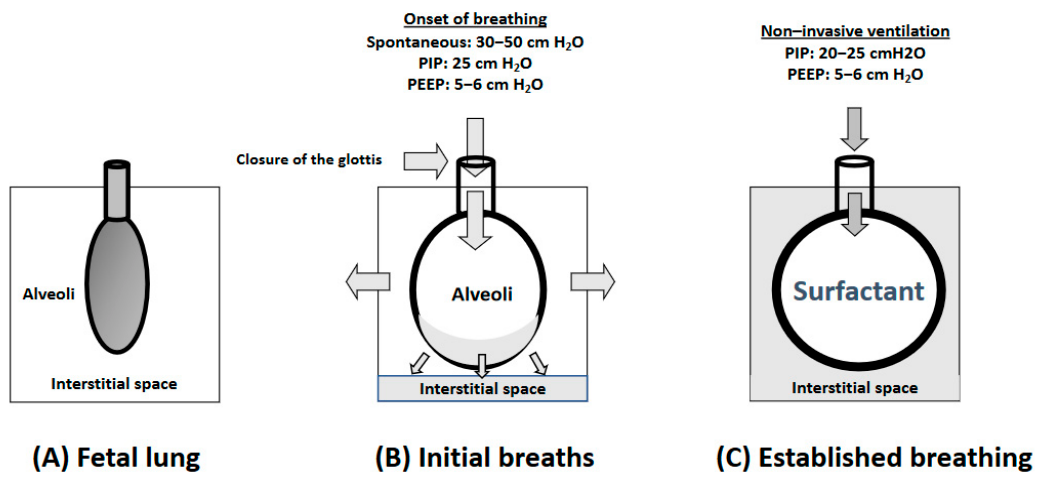
Figure 1. In fetal life, lung and respiratory airways are filled with fluid ( panel ( A )). Immediately after birth, intense respiratory efforts generating intense pressures extrude lung fluid to the interstitium, and closure of the glottis and surfactant distribution in the surface of the alveoli contributes to establishing a functional residual capacity ( panel ( B )). Ongoing respiratory efforts once the FRC has been established require less positive inspiratory pressures (PIP) and positive-end expiratory pressures (PEEP) to maintain an adequate gas exchange ( panel ( C )).